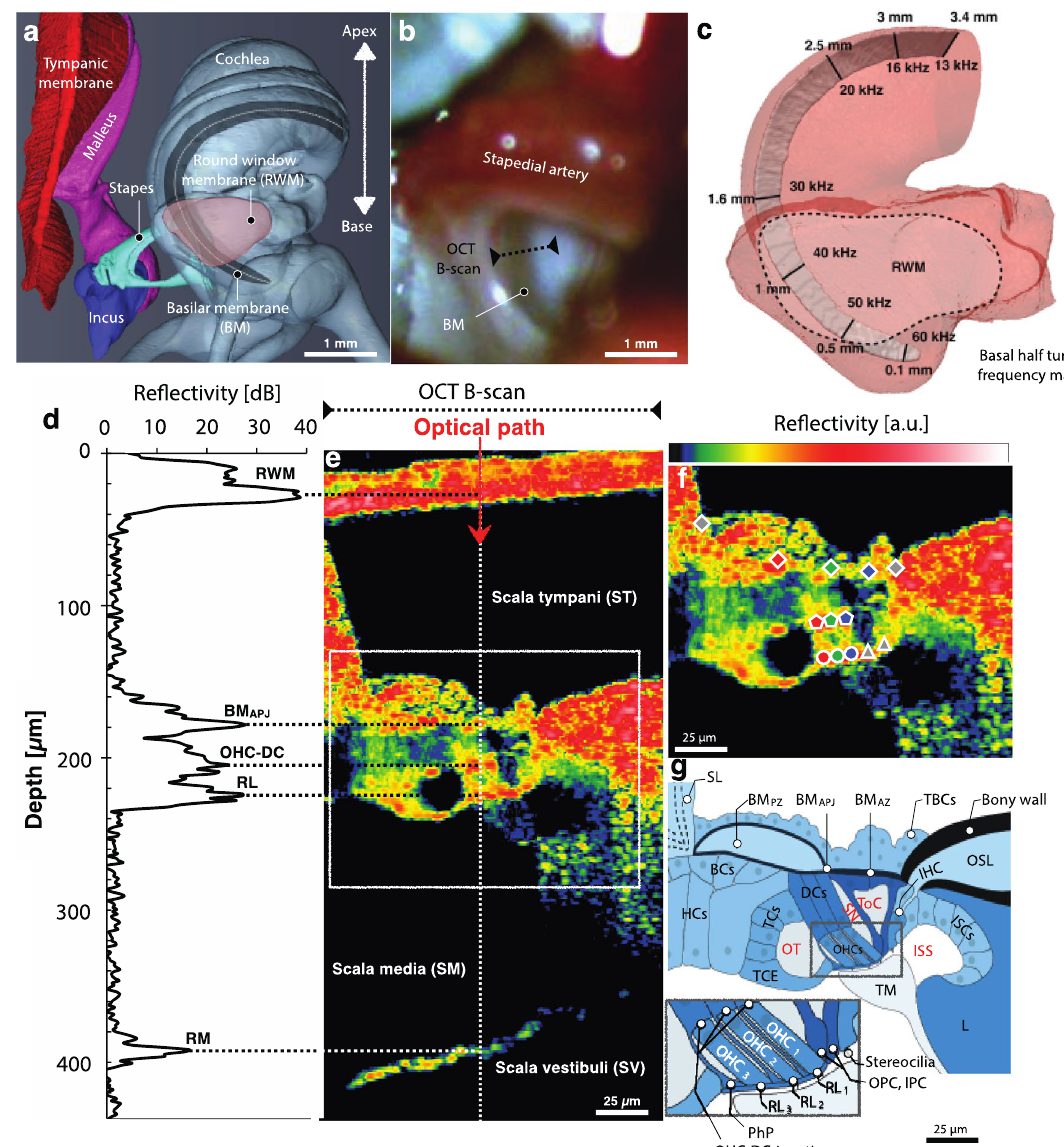
Figure 1. The anatomy of the gerbil ear and in vivo cochlear imaging. ( a ) A micro-computed-tomography (µCT)–based 3D reconstruction shows the main structures of the gerbil middle ear (i.e., tympanic membrane, malleus, incus, and stapes), and the cochlea (base to apex) with the round-window membrane (RWM; pink region) and internal basilar membrane (BM; dark-gray region) indicated. ( b ) A photograph (specimen G504) shows the RWM region through which 2D “B-scan” cross sections of the BM in the basal “hook region” of the cochlea can be imaged using optical coherence tomography (OCT; black dotted line). ( c ) The frequency map of the BM “basal half turn” (from panel a ) is shown as a function of distance from the basal tip. ( d ) An example of the depth profile (backscattered-light reflectivity) of a single 1D “A-scan” (white dotted line in ( e ) shows several peaks corresponding to: the RWM; the junction (BM APJ ) of the BM arcuate zone (BM AZ ) and pectinate zone (BM PZ ); the junction (OHC-DC) of an outer hair cell (OHC) and Deiters’ cell (DC); the reticular lamina (RL); and Reissner’s membrane (RM). ( e ) An in vivo OCT B-scan image (G612), as measured through the RWM. ( f ) Enlarged view of e detailing the organ of Corti (OoC) structure and marking the following OCT-vibrometry measurement points (left to right and top to bottom): outer BM edge, BM PZ , BM APJ , BM AZ , inner BM edge (gray/ red/green/blue/gray diamonds); OHC-DC-junction 3,2,1 (red/green/blue pentagons); RL 3,2,1 (red/green/blue circles); and outer and inner pillar cells (OPC and IPC; gray triangles). ( c , g ) Drawing by Andrew A. Tubelli. ( g ) A labeled cross-sectional drawing of a representative OoC structure. The inset details the three rows of OHCs where they meet the RL at their apical ends, as well as the OPC, IPC, and inner-hair-cell (IHC) stereocilia. Other abbreviations: SL, spiral ligament; TBCs, tympanic border cells; BCs, Boettcher cells; OSL, osseous spiral lamina; HCs, Hensen’s cells; TCs, tectal cells; TCE, tectal-cell extension; ISCs, inner-sulcus cells; TM, tectorial membrane; L, limbus; OT, outer tunnel; SN, Space of Nuel; ToC, tunnel of Corti; ISS: inner spiral sulcus; PhP, phalangeal